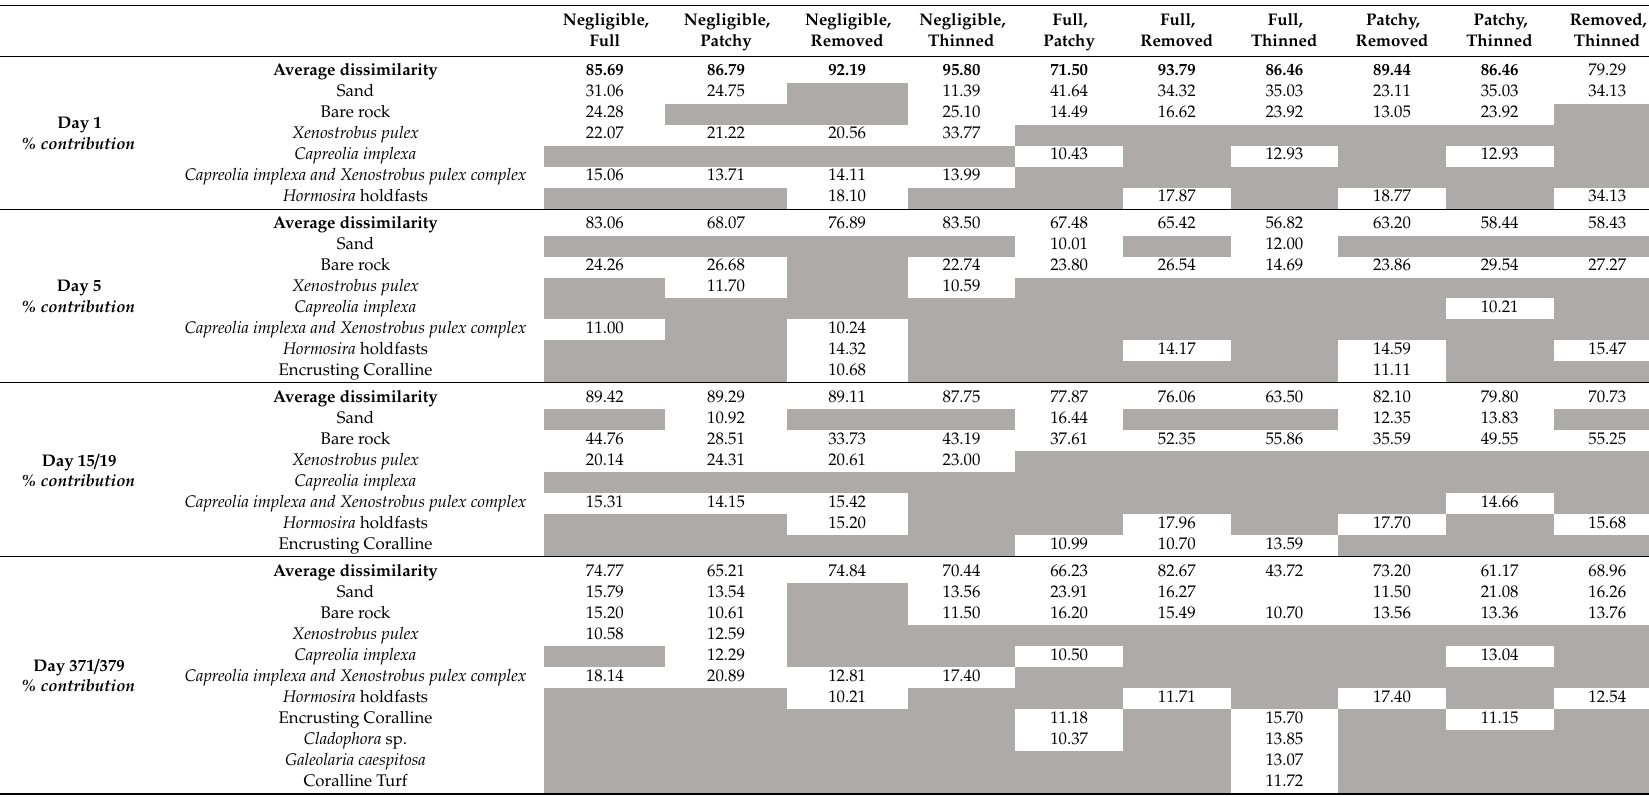
Table A2. Summary SIMPER table: Average dissimilarity of treatment pairs for understorey cover combining Bridgewater Bay and 13th Beach. Contributions > 10% given by understorey component /